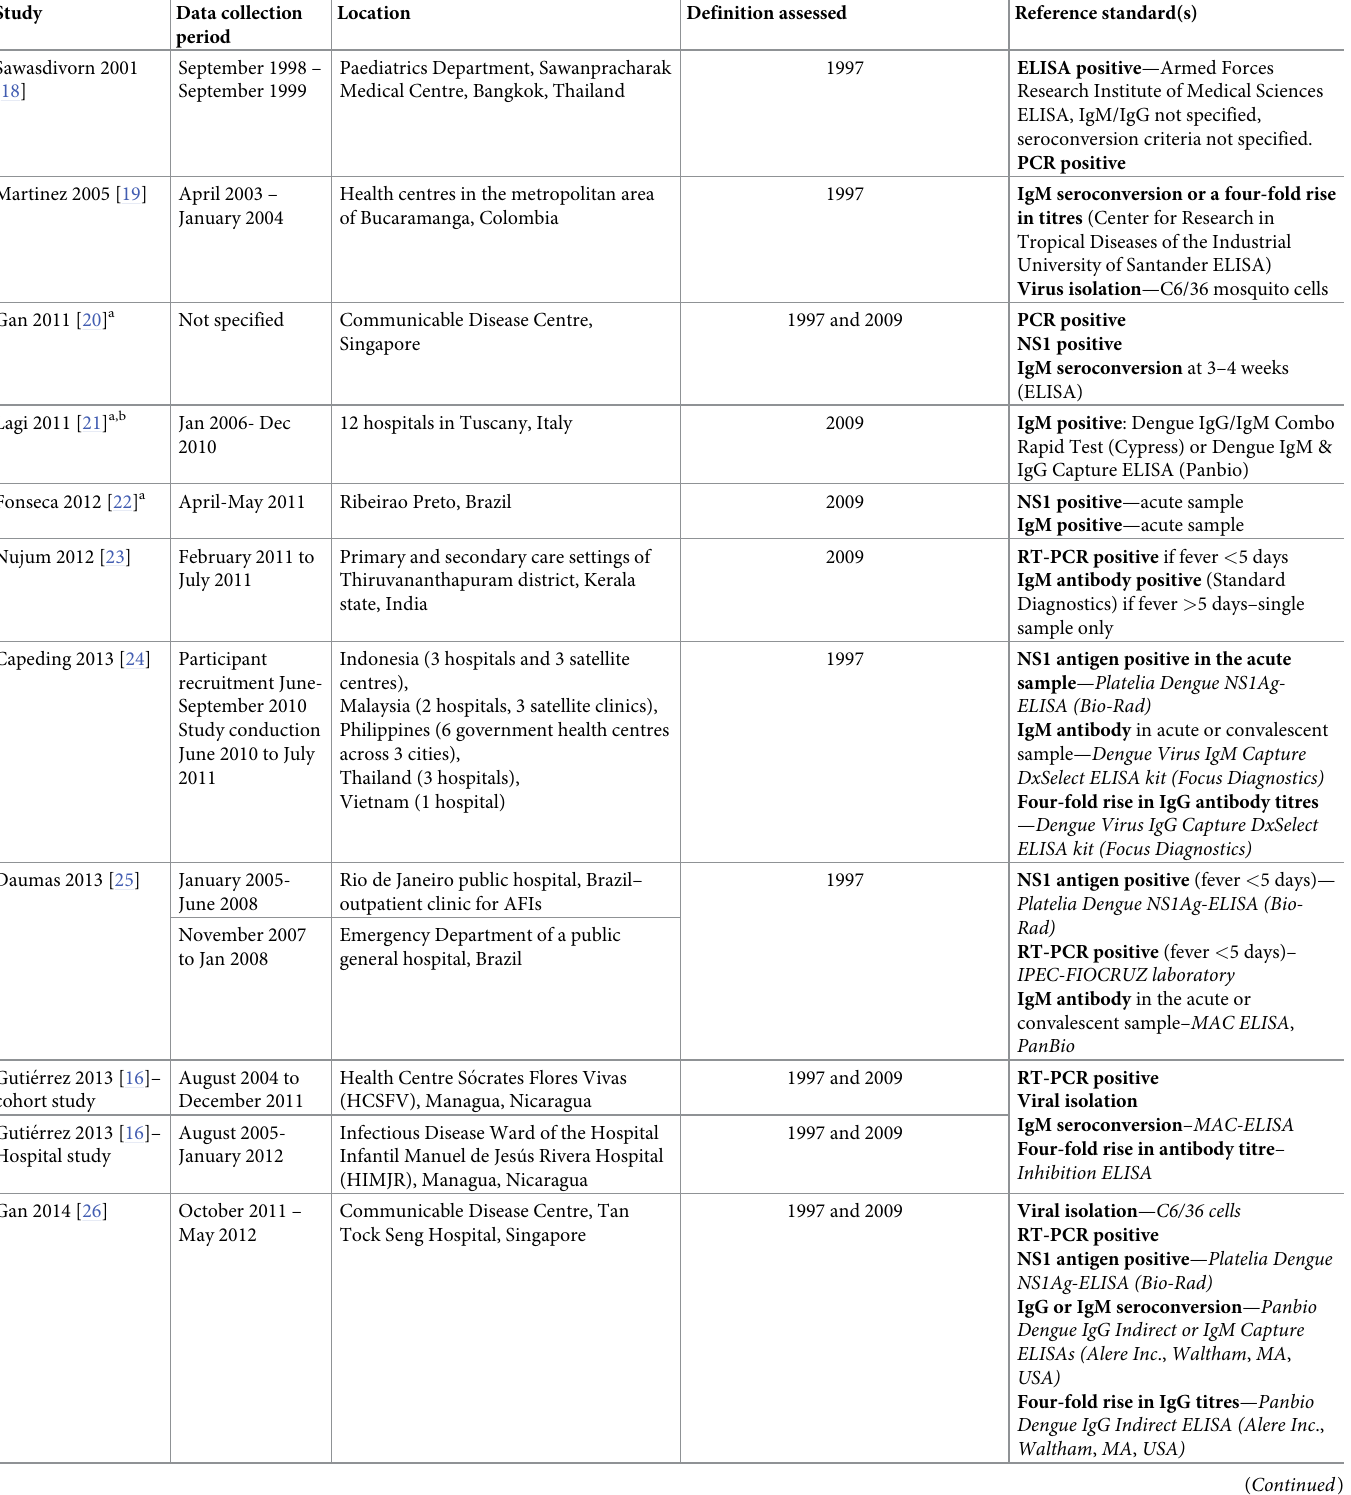
Table 3. Characteristics of studies included in the systematic